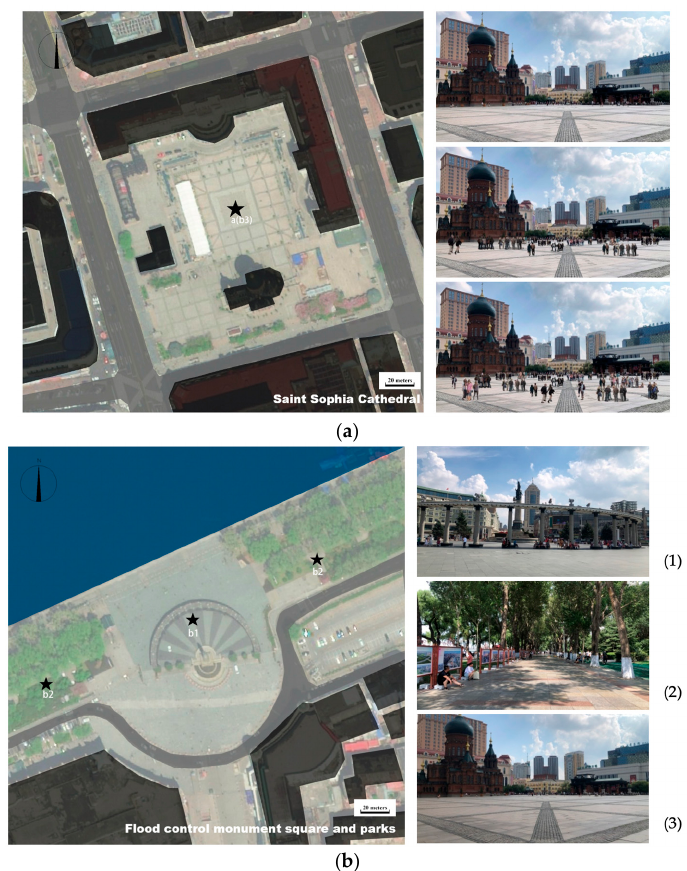
Figure 2. Landscape recorded: ( a ) crowd density; and ( b ) three environment